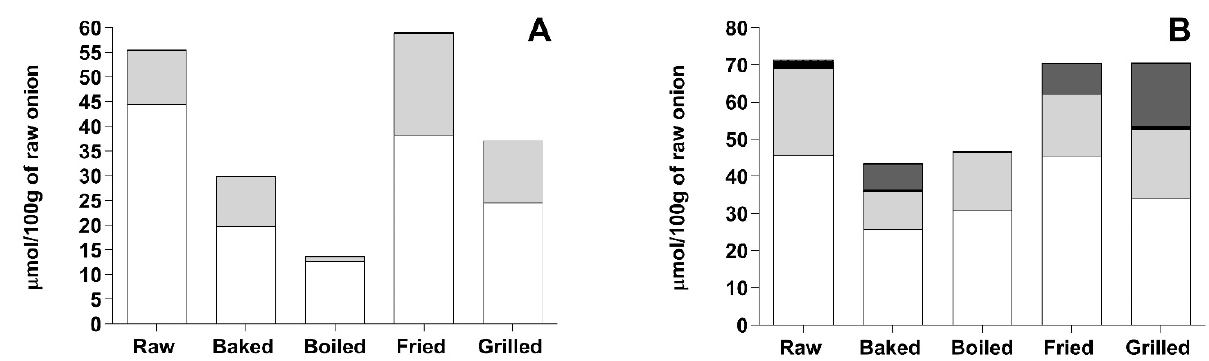
Figure 3. Sum of the molar concentrations of quercetin-derivatives and the degradation product protocatechuic acid-hexoside in YSO and RSO as affected by the cooking method. The data are referred to the original fresh weight and expressed as µ mol of compound/100 g of fresh weight. ( A ) YSO; ( B ) RSO. Reported compounds are total quercetin-di-hexosides (white), total quercetin-mono-hexosides (light grey), quercetin (black) and protocatechuic acid-hexoside (dark grey).